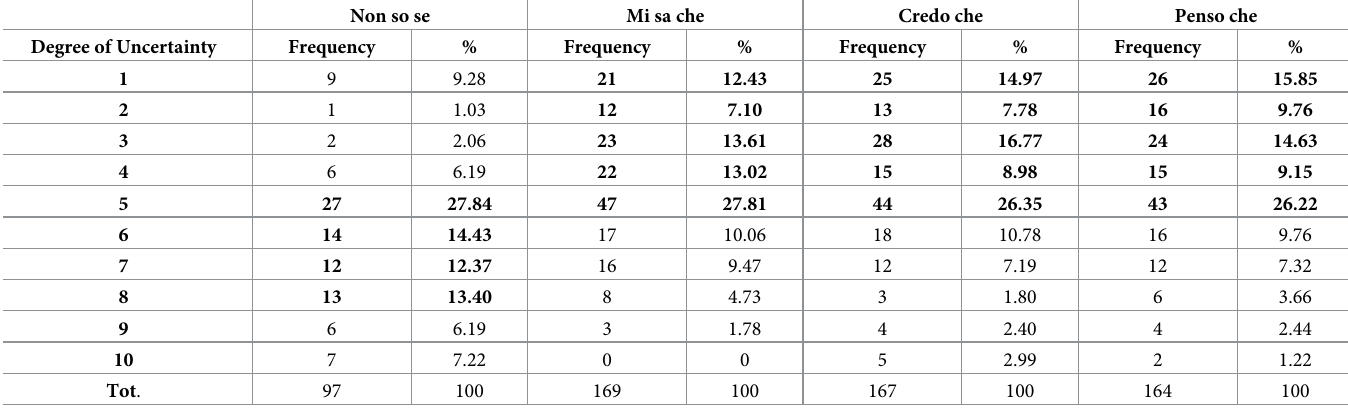
Table 5. Degrees of uncertainty assigned to the sentences (3) Non so se p , (4) Mi sa che p , (5) Credo che p , (6) Penso che p . Degree of